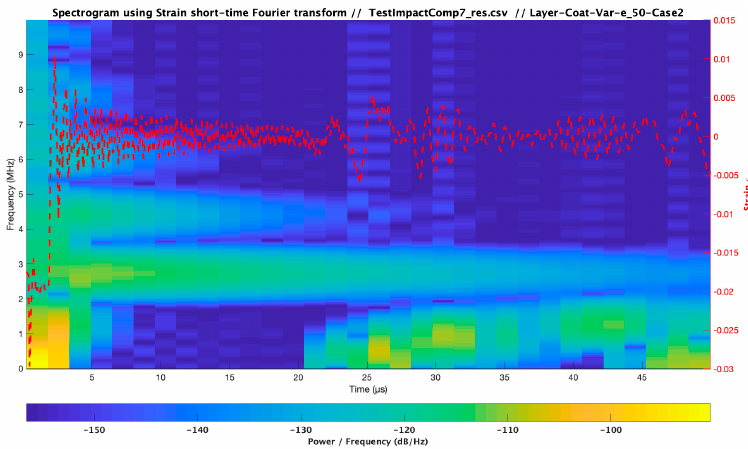
Figure 35. Spectrogram for strain evolution at the middle coating layer, 50% thickness, considering substrate-filler as semi-infinite with variation in droplet velocity. Case 2.